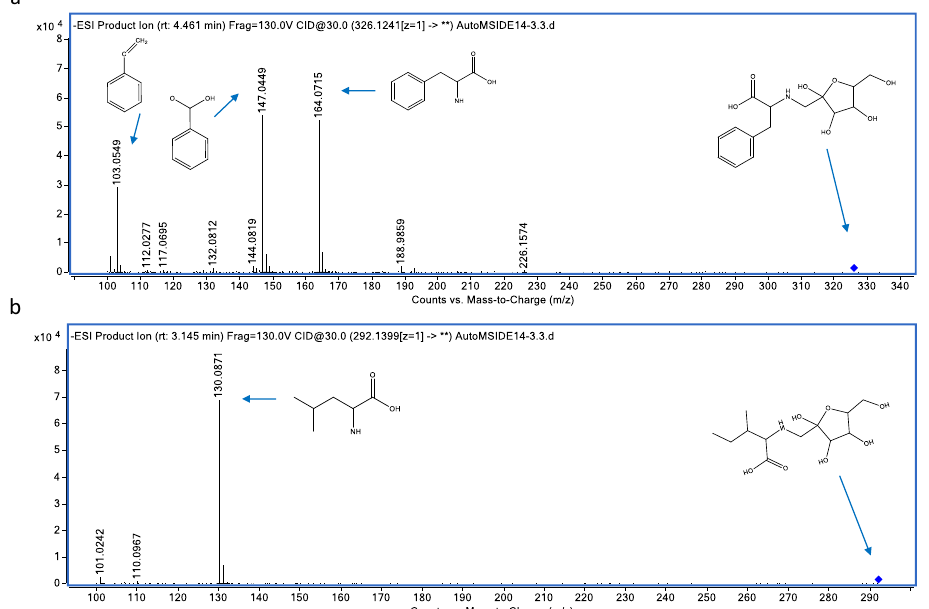
Figure 4. MS/MS fragmentation spectra plot of N-(1-Deoxy-1-fructosyl)phenylalanine and N-(1-Deoxy-1-fructosyl)isoleucine at 30 ev of collision energy. ( a ) MS/MS fragmentation spectra of N-(1-Deoxy-1-fructosyl)phenylalanine; ( b ) MS/MS fragmentation spectra of N-(1-Deoxy-1-fructosyl)isoleucine.